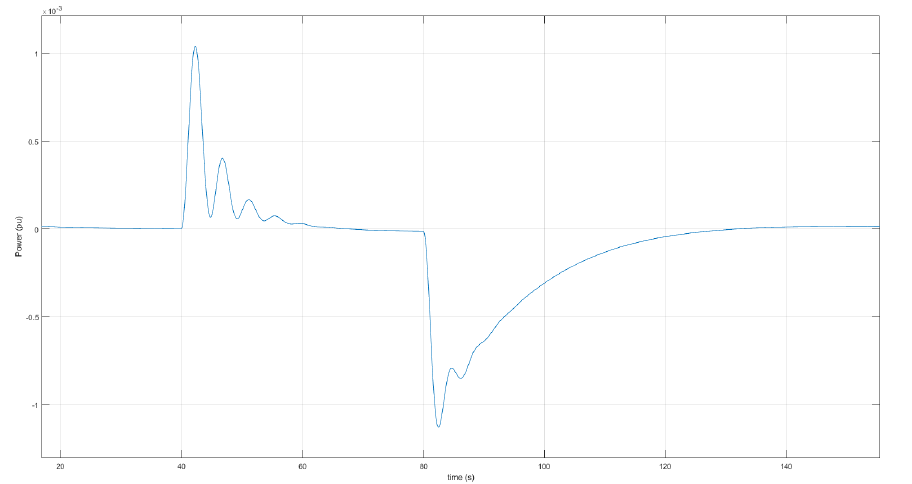
Figure 18. The tie-line power between two areas.